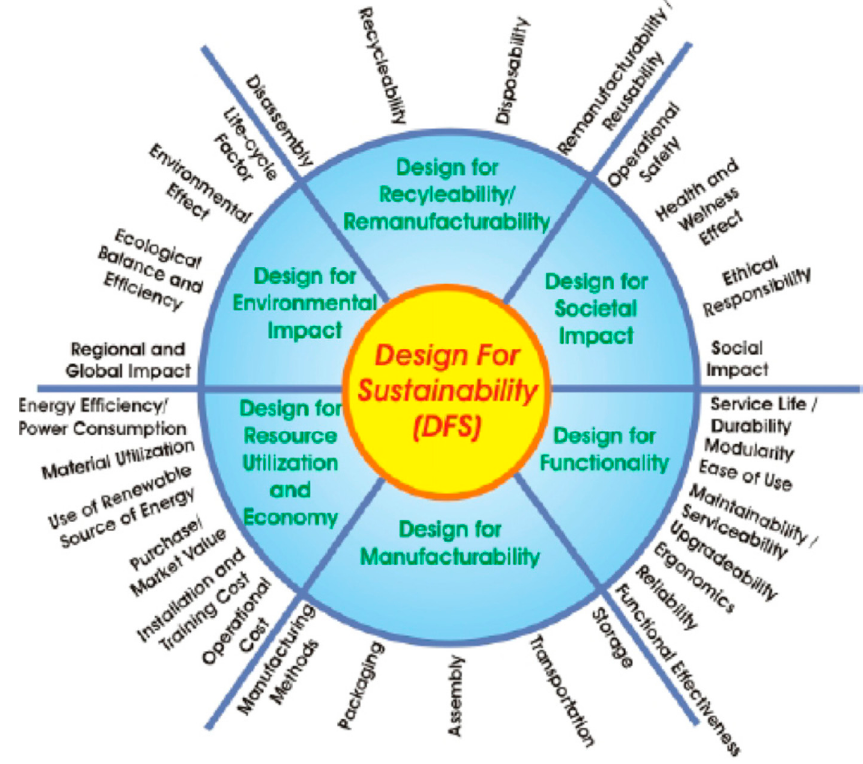
Figure 8. Elements within DfS. Adapted with permission from Ref. [47]. Copyright 2007 Dialnet.